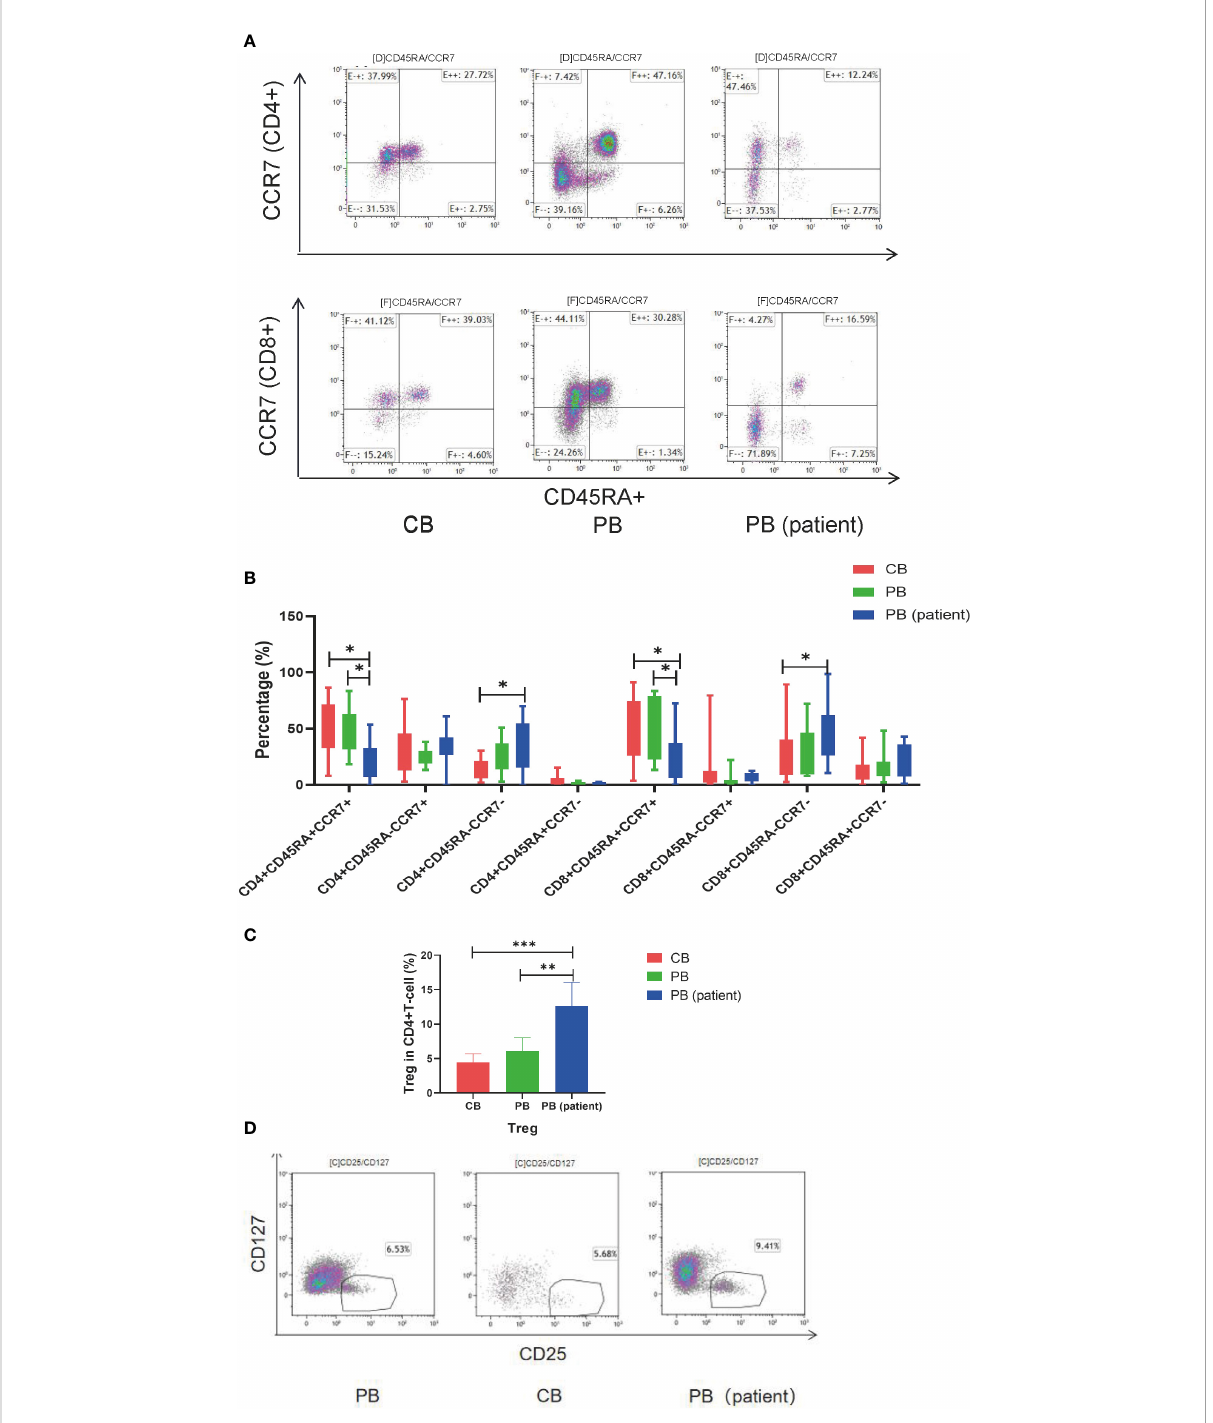
FIGURE 1 T-cell subsets of CB, PB, and PB (patient) groups. (A) Flow cytometry analysis of TN, TCM, TEM, and TEMRA in the three groups of T cells. Right upper quadrant: naive T (CD45RA+CCR7+), left upper quadrant: TCM (CD45RA-CCR7+), left lower quadrant: TEM (CD45RA-CCR7-), and right lower quadrant: TEMRA (CD45RA+CCR7-). (B) TN, TCM, TEM, and TEMRA in the three groups of T cells. (C) Proportion of Tregs in the three groups of T cells. (D) Flow cytometry analysis of Tregs (CD4+CD25+CD127-). TN, Naive T cell; TCM, Central memory T cell; TEM, effector memory T cell; TEMRA, Terminal effector T cell; Treg, regulatory T cell. *p < 0.05, **p < 0.01, ***p <